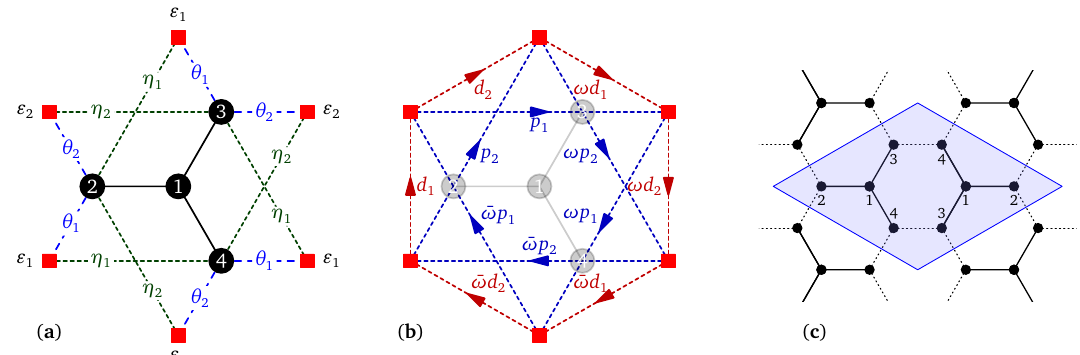
Figure 2: Schematic representation of the impurity model used in this work. Each cluster is made of four lattice sites (numbered black dots) and six bath orbitals (red squares). The normal-state bath parameters are shown on Panel (a): Two differ- ent bath energies (cid:34) , four different hybridizations θ and η . The anomalous 1,2 1,2 1,2 bath parameters are shown on Panel (b). As shown, they are optimized for study- ing the p + ip state: Two complex-valued triplet pairings d between “nearest- 1,2 neighbor” bath orbitals, and two other complex-valued triplet pairings p between 1,2 “second-neighbor” bath orbitals, all modulated by powers of the complex amplitude ω = e 2 π i / 3 as one goes around ( ¯ ω = ω 2 = ω − 1 ). The unit cell of the impurity model contains four copies of this cluster: Two on the bottom level ( w ), two on the top 1,3 level ( w ). On each level, they are arranged as shown on Panel (c) (the 4-site clus- 2,4 ter on the right is the inversion of the one on the left, and the bath parameters are the same on the two clusters, except for the sign of the triplet pairings, which are